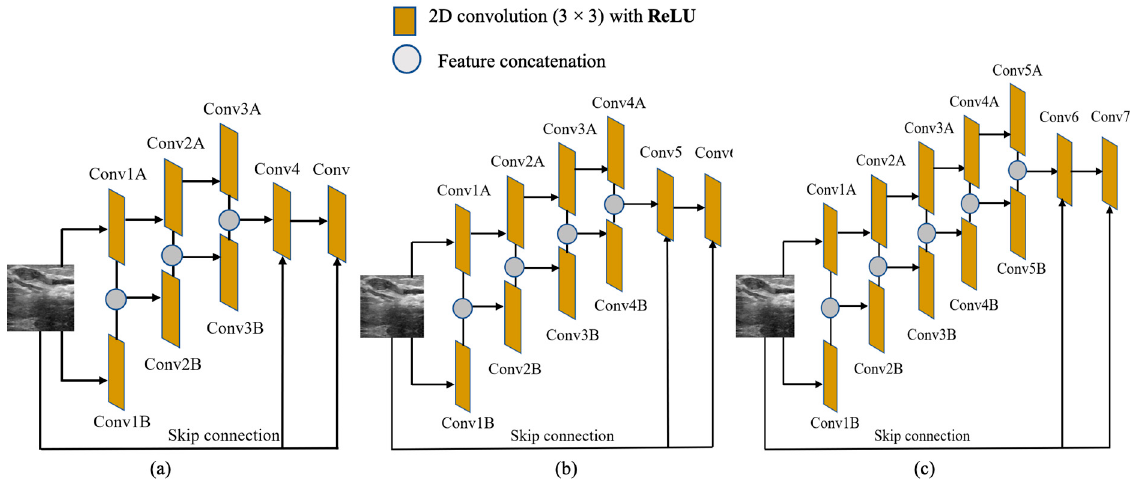
Figure 7. FEN with varying depth. ( a ) 𝑀 = 3 , ( b ) 𝑀 = 4 , and ( c ) 𝑀 = 5 .